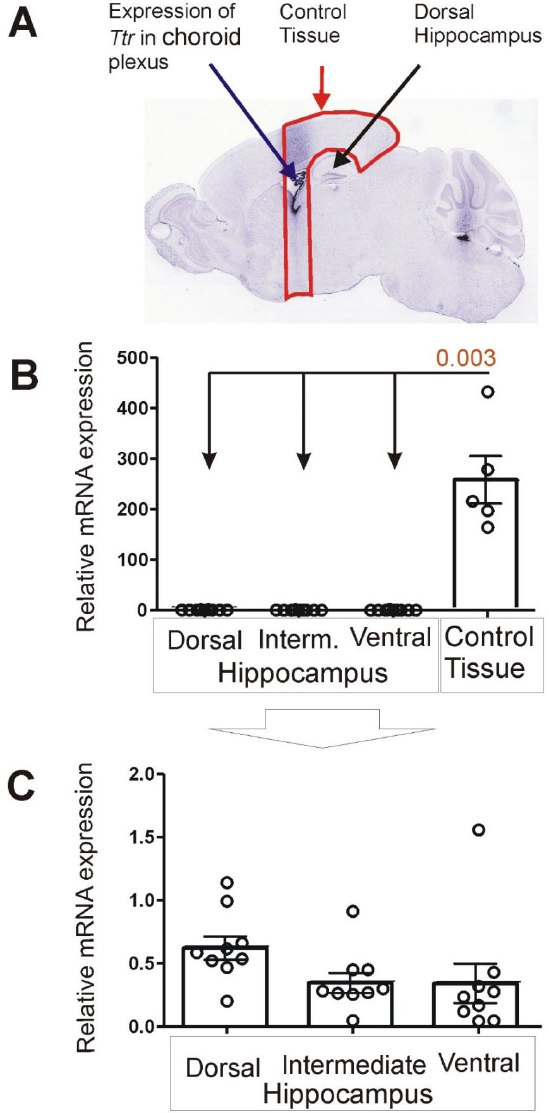
Figure 5. Brain expression of Ttr . ( A ) Pattern of expression in choroid plexus and dorsal hippocampus (ISH image) derived from Allen Mouse Brain Atlas (https://mouse.brain-map.org/, accessed on 23 June 2021) [13]. ( B ) Results of PCR analysis performed on control tissue and dissected samples of dorsal, intermediate and ventral hippocampus. ( C ) Details of Ttr expression in hippocampal subdivisions presented with altered scale at the Y axis. Data are presented as mean ± SEM (column bar graphs) overlaid on scatter plots.